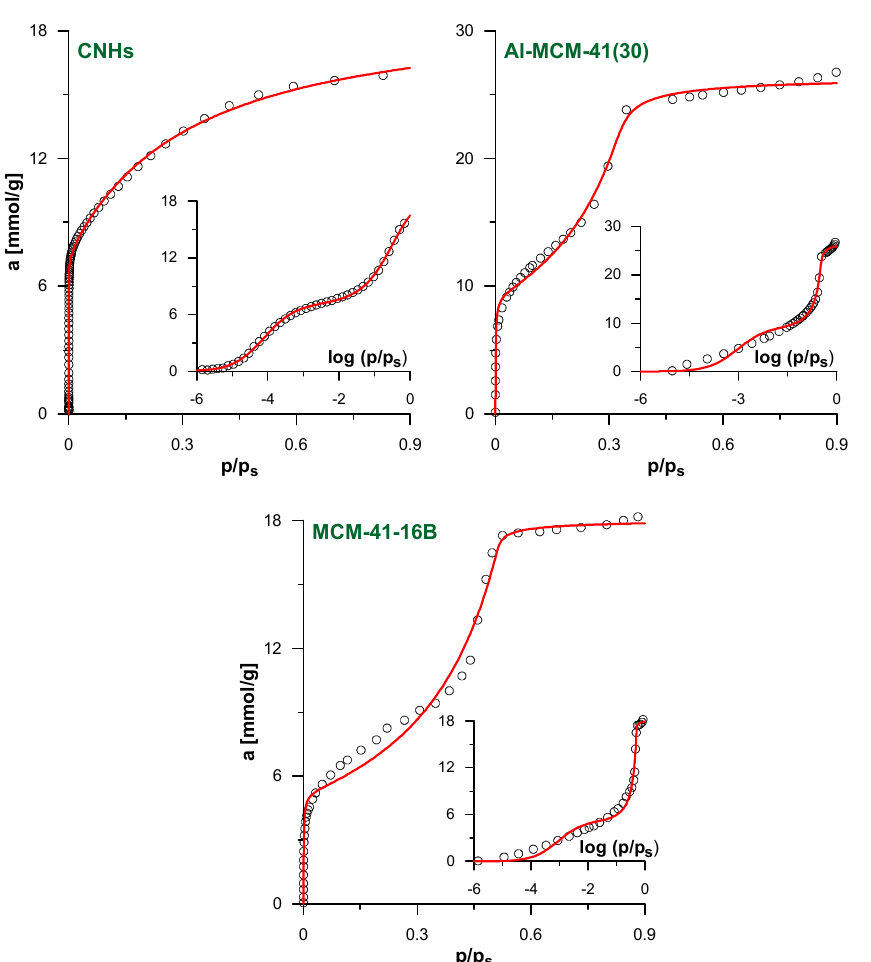
Figure 4. The results of the fitting of experimental N 2 adsorption isotherms by fpv-GAB (Equations (4)–(8)) and fpv-GAB-li (Equations (4)–(6) and (8)–(10)) models for the samples CNHs, Al-MCM-41(30) and MCM-41-16B. The insets show the same data in logarithmic scale of the relative pressure. The points represent experimental data and lines reflect the predictions of the models. Since fpv-GAB-li equation is simplified to fpv-GAB ( A ≈ 0) only one theoretical line is plotted for each system. In the case of CNHs and MCM-41-16B only selected experimental points are shown for